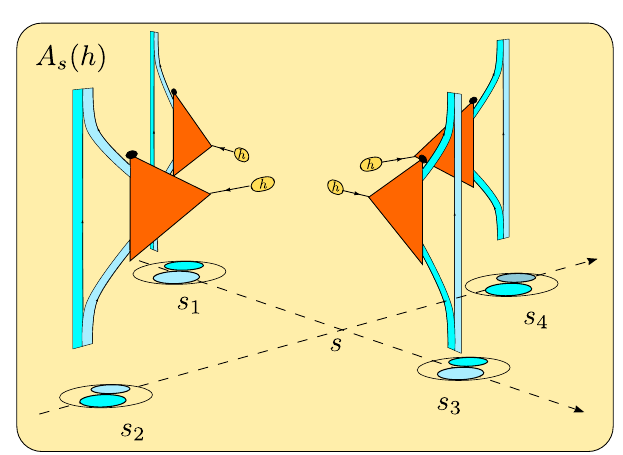
FIG. 17. The operator that generates gauge transformations in the gauge magnet LGT defined in Eq. (35). It rotates both incoming and outgoing links by the same group elements. On every link, it only acts on the constituent that is closer to the